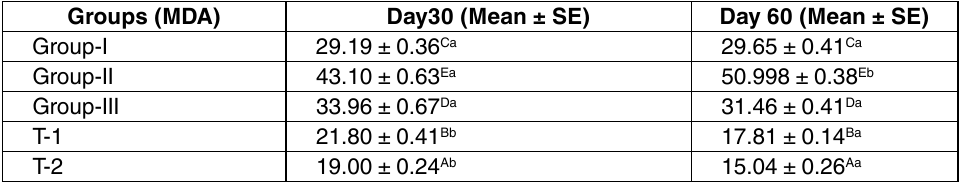
table 11. The mean ± SE MDA level (nmol/mg protein) in liver tissue collected from rats under different treatment